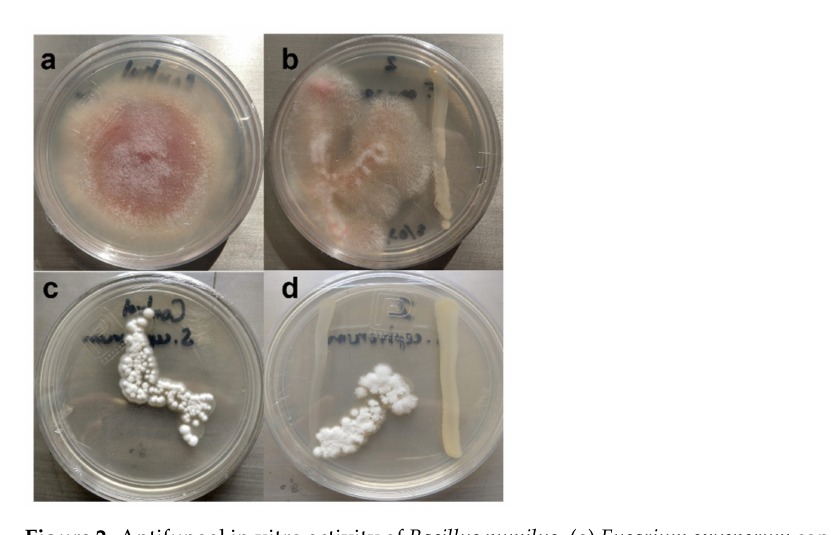
Figure 2. Antifungal in vitro activity of Bacillus pumilus . ( a ) Fusarium oxysporum control, ( b ) antifungal activity of B. pumilus against Fusarium oxysporum , ( c ) Sclerotium cepivorum control, ( d ) antifungal activity of B. pumilus against Sclerotium cepivorum